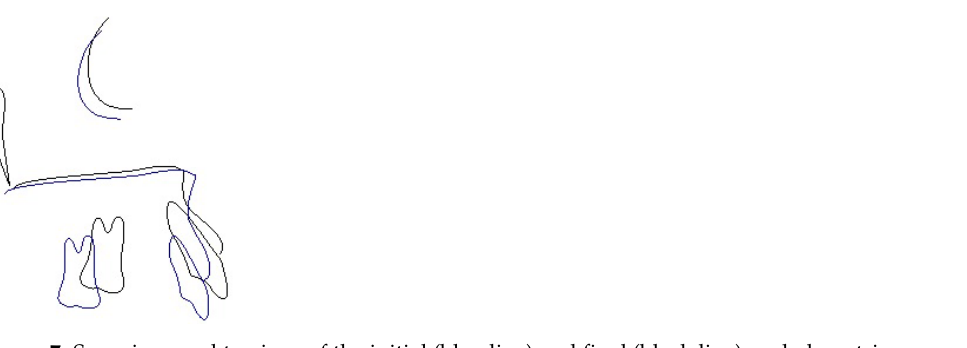
( c ) Figure 8. After 24 months from debonding photographic examination: ( a ) Facial aspect: frontal view, profile, ¾ profile on smiling; ( b ) Intra -oral aspect: lateral right, frontal and lateral left; ( c ) Intra -oral aspect: occlusal view.